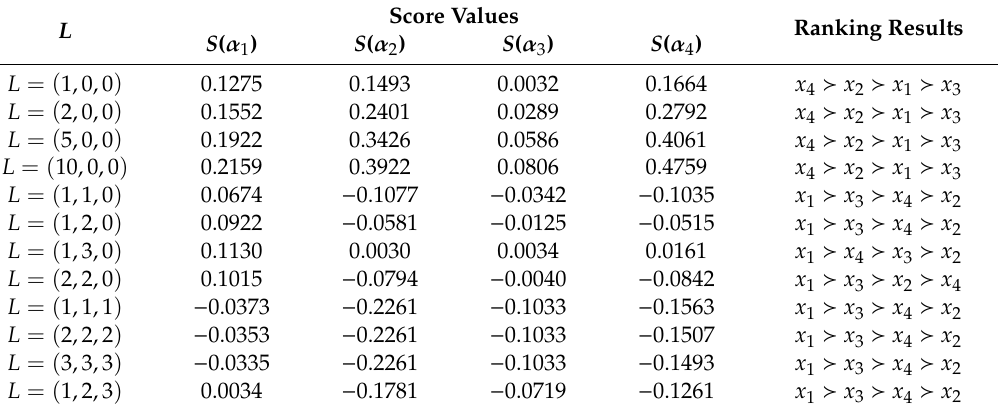
Ranking Results